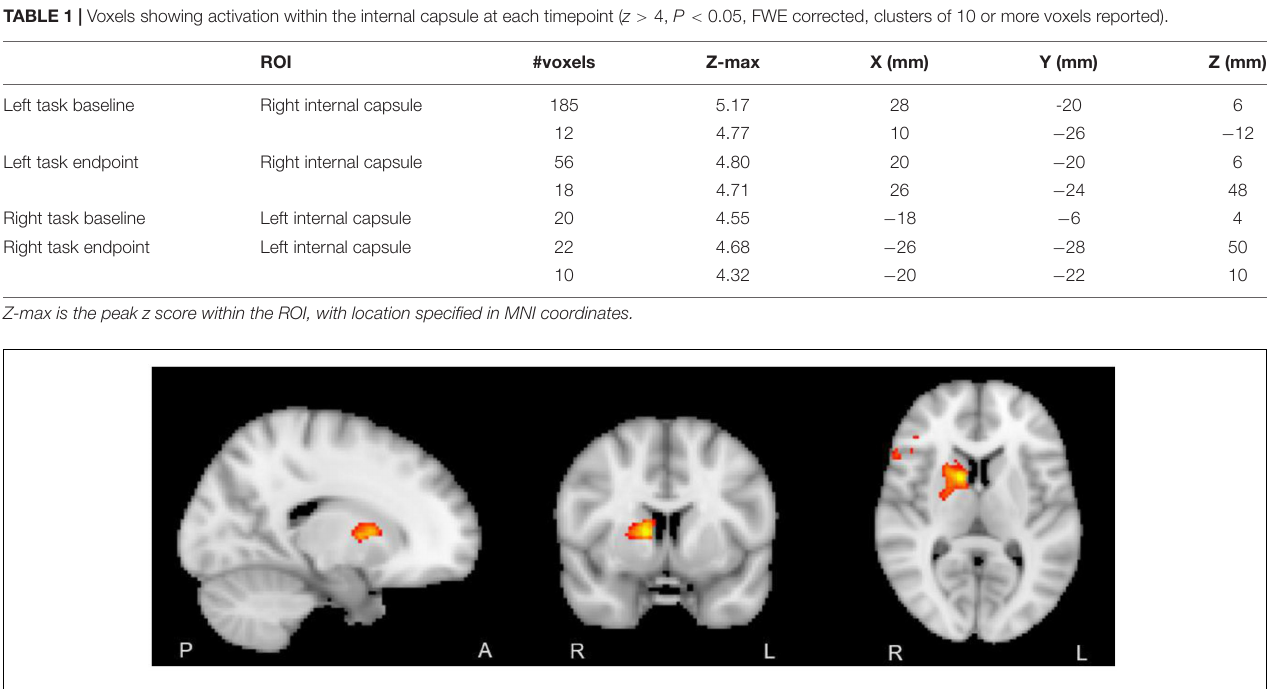
critical for obtaining a holistic representation of brain